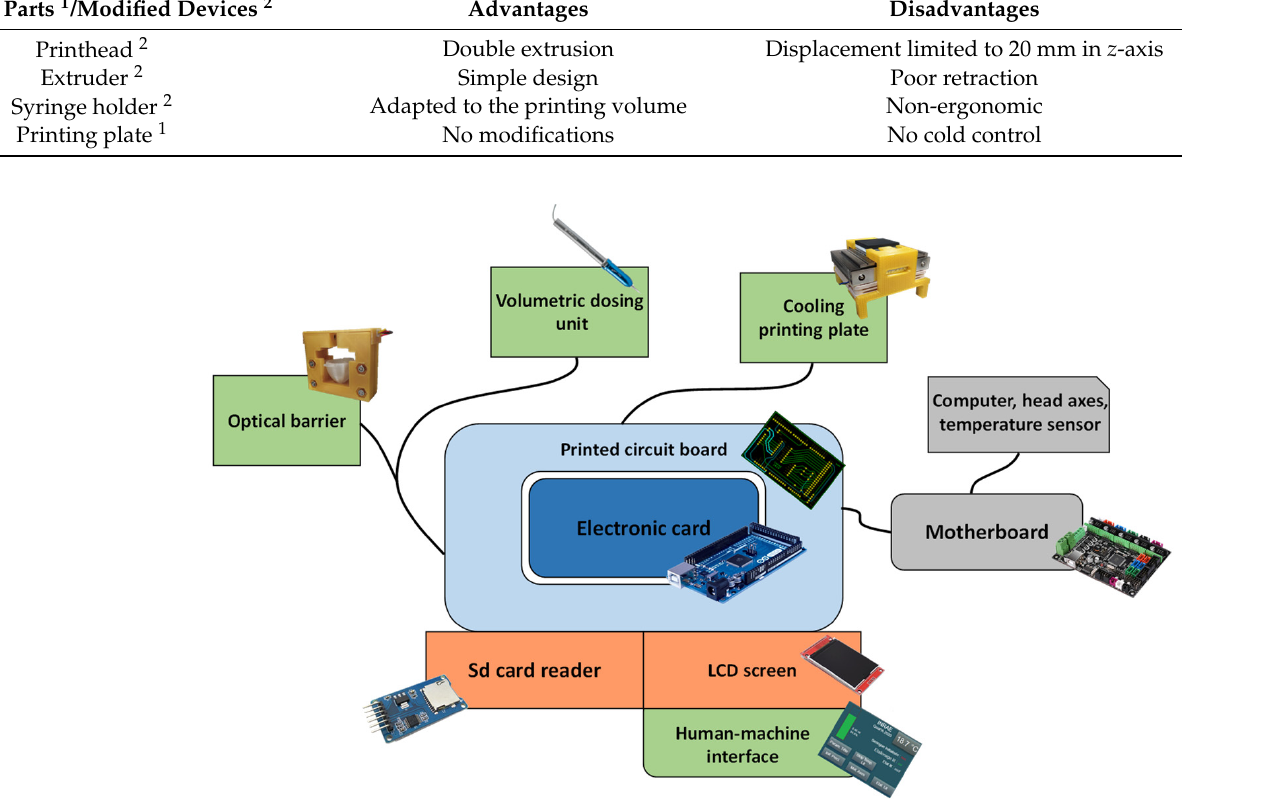
Figure 2. Schematic representation of the various electronically controlled components of the 3D food printer built. “Supplementary Materials S1” gives accurate information about the connectivity between the different added elements.